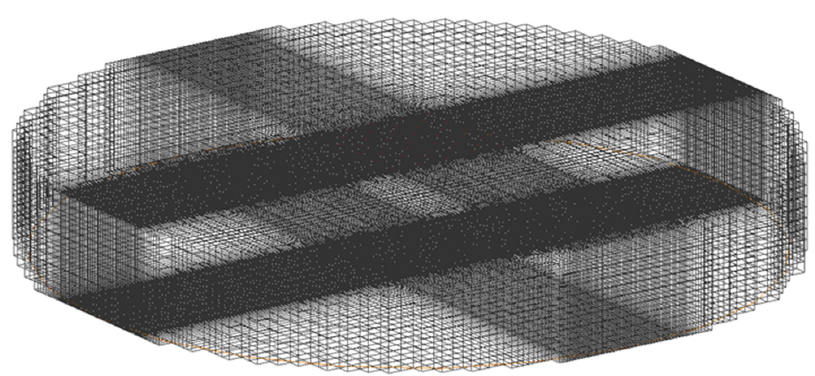
Figure 3. Schematic diagram of model meshing (z ‐ axis magnified 2.5 times).